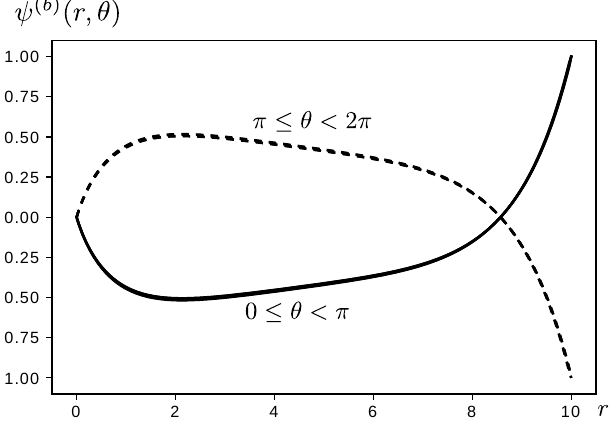
Figure 5. Solution to ψ ( b ) ( r , θ ) for different values of θ in units in which m = 1. The continuous line shows the solution for θ = { π N = 256 and L =